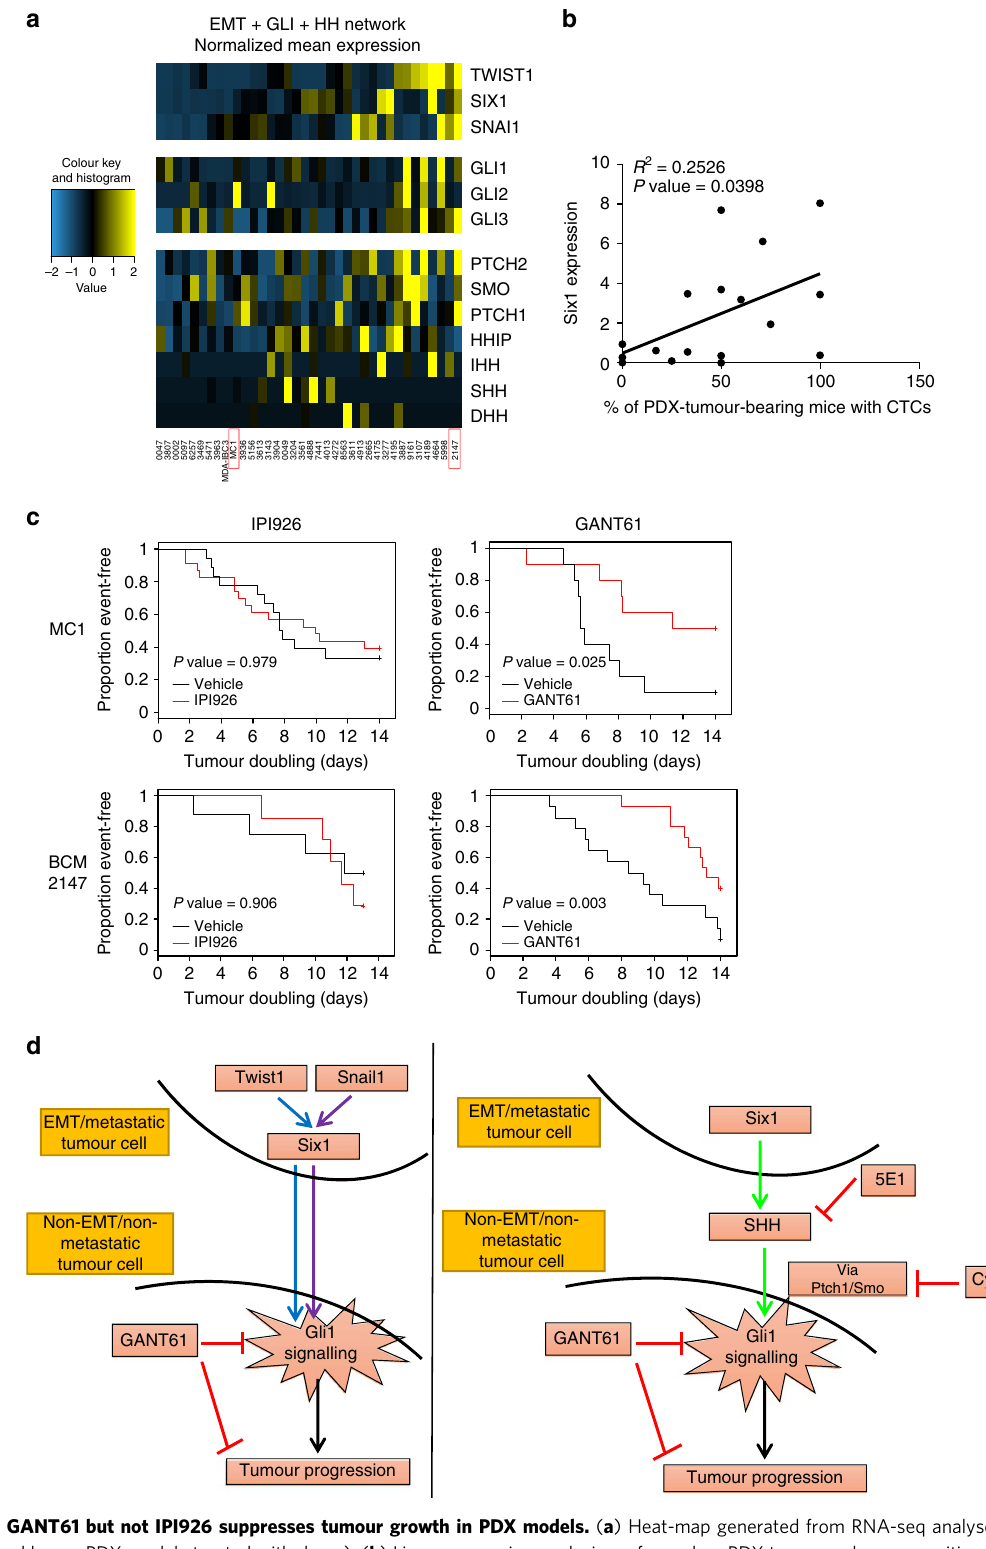
Figure 8 | GANT61 but not IPI926 suppresses tumour growth in PDX models. ( a ) Heat-map generated from RNA-seq analyses performed on PDX tumours (red boxes-PDX models treated with drugs). ( b ) Linear regression analysis performed on PDX tumours shows a positive correlation between Six1 mRNA expression and the percentage of PDX-tumour-bearing mice with circulating tumour cells (CTCs). ( c ) Kaplan–Meier curves depicting tumour doubling times for MC1 and BCM-2147 PDX models treated with IPI926 and GANT61. Comparisons between IPI926/GANT61 and vehicles were made using Wilcoxon test. ( d ) Graphical summary of paper which demonstrates that EMT-TFs can induce GLI activation in neighbouring cells not expressing the EMT-TFs, and that this activation can occur either via canonical or non-canonical means. In either case, the activation of GLI1 in neighbouring cells results in the attainment of aggressive properties, leading to tumour progression which can be inhibited by